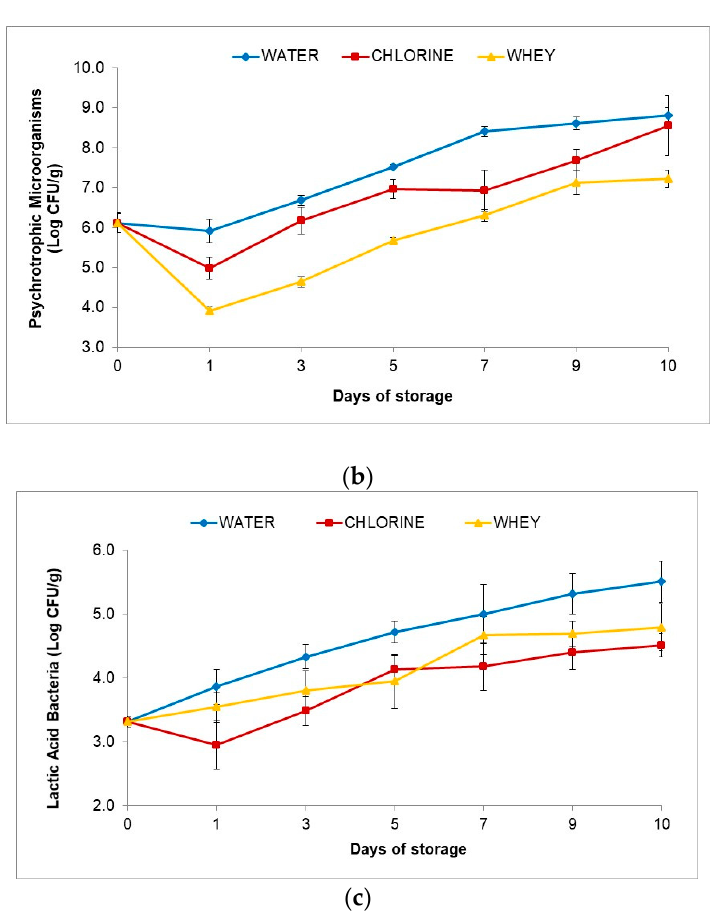
Figure 7. Packed shredded lettuce: effect of sanitation on shredded lettuce Aerobic Microorganisms ( a ), Psychotropic Microorganisms ( b ), and Lactic Acid Bacteria ( c ) over 10 days in cold storage. Results represent the average of at least three replicate experiments (n = 3) ± SD.